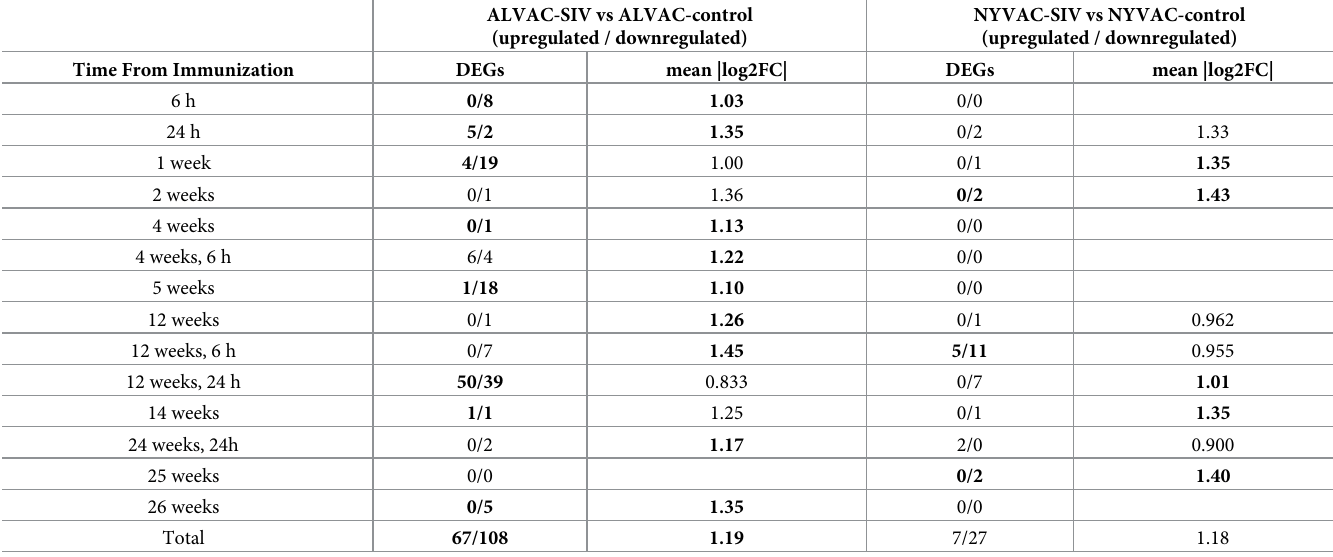
Number of genes differentially expressed (cutoff: LIMMA adj. p � 0.05) and average log fold-change for ALVAC-SIV and NYVAC-SIV compared to their respective controls. The bold number indicates the greatest number of differentially expressed genes (DEGs) between ALVAC-SIV and NYVAC-SIV and the strongest